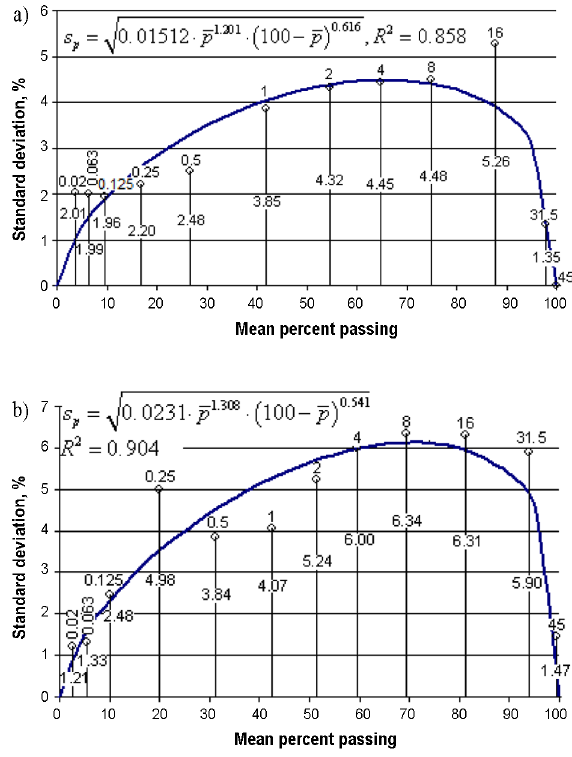
Fig. 13. Correlation between the statistical parameters of ASB mixture gradation: a – in a stockpile; b – in a railway sub- ballast